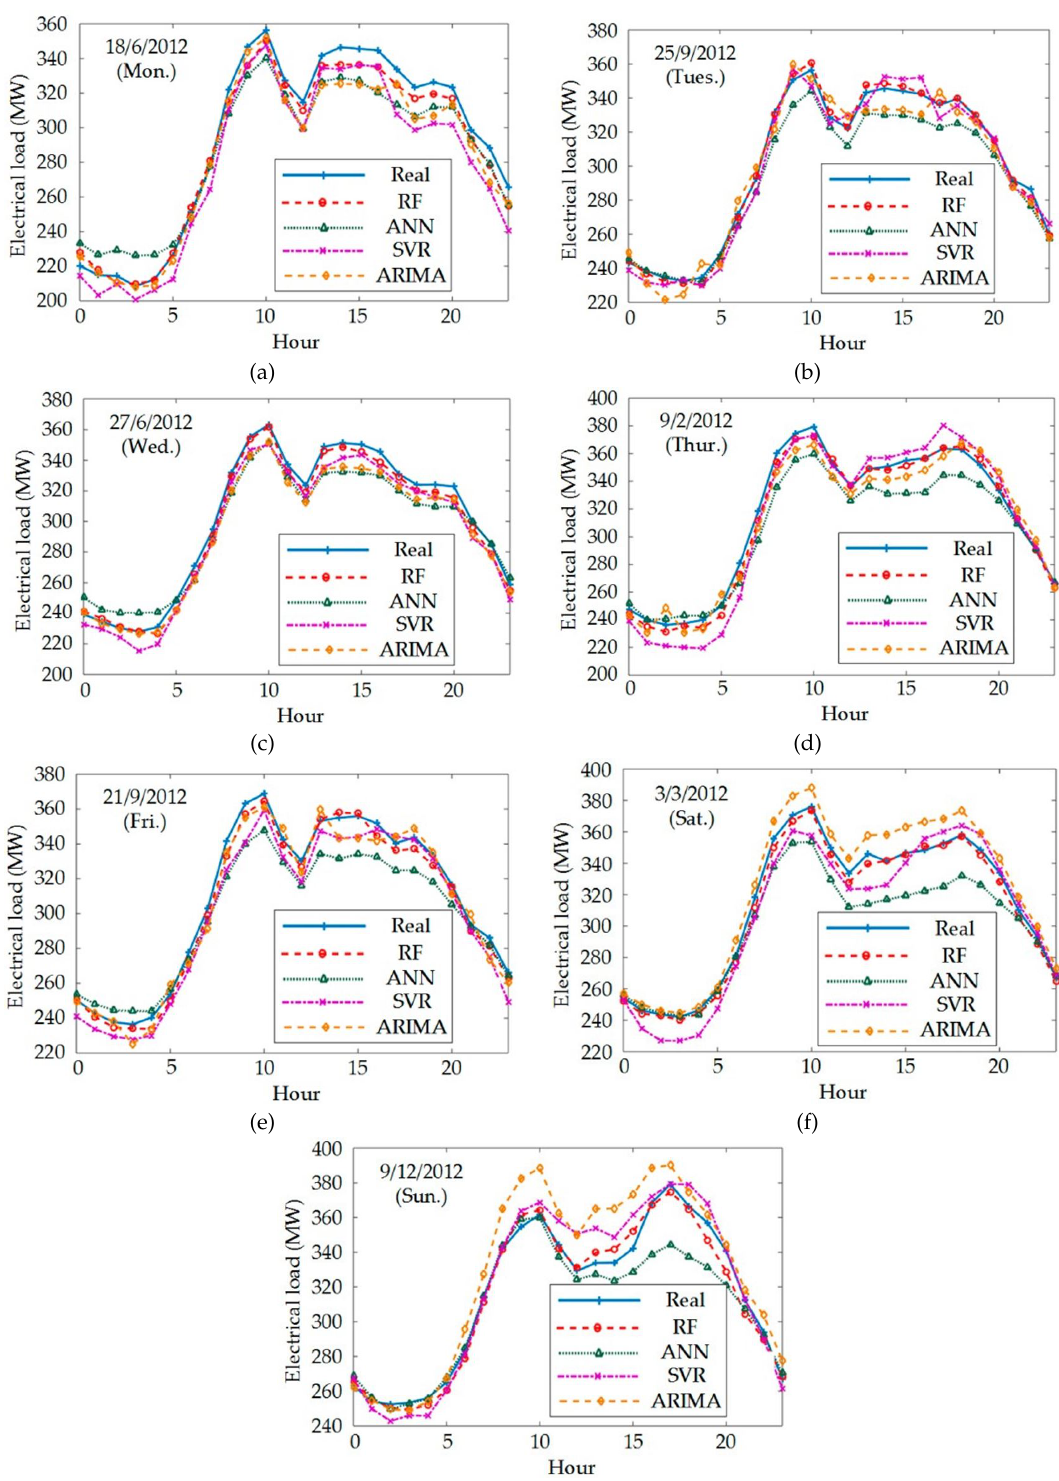
Fig. 5. (a) The comparison of prediction results obtained from day-ahead prediction of June 18th; (b) the comparison of prediction results obtained from day-ahead prediction of September 25th; (c) the comparison of prediction results obtained from day-ahead prediction of June 27th; (d) the comparison of prediction results obtained from day-ahead prediction of February 9th; (e) the comparison of prediction results obtained from day-ahead predic-tion of September 21st; (f) the comparison of prediction results obtained from day-ahead prediction of March 3rd; (g) the comparison of prediction results obtained from day-ahead prediction of December